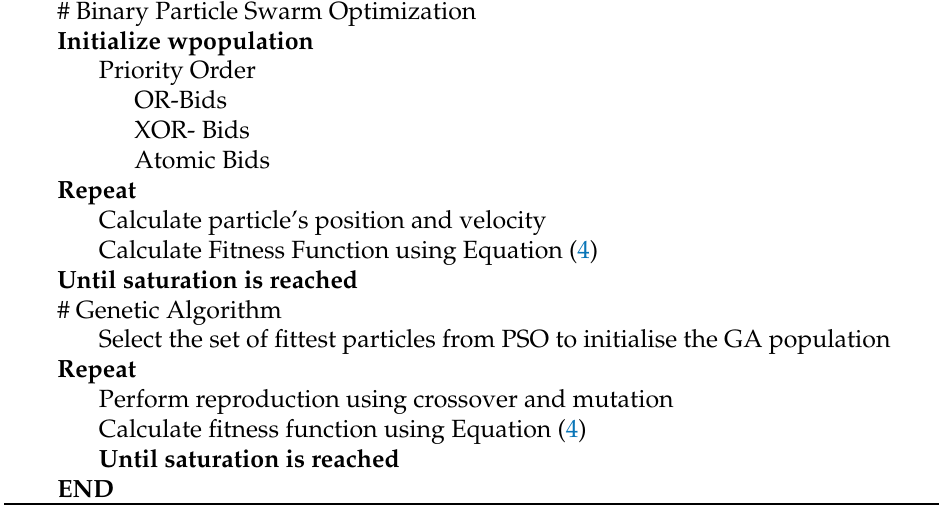
Algorithm 1: Hybrid GA and BPSO For Combinatorial Auction (AUCGENPSO)